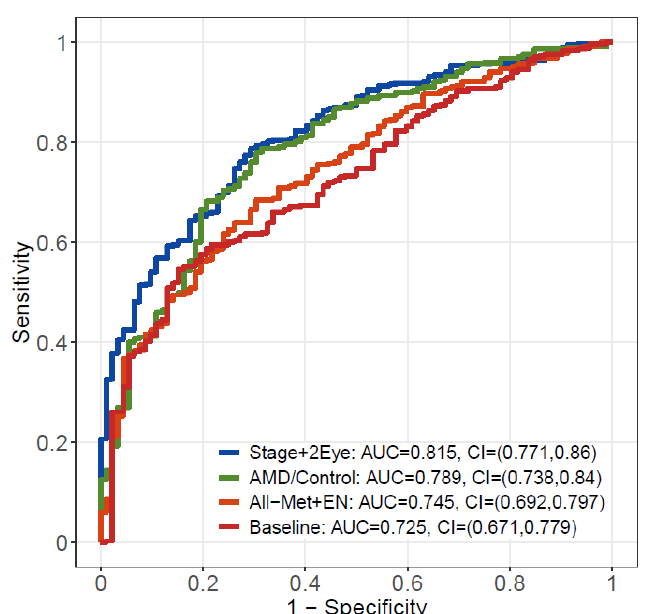
Figure 4. Receiving operating characteristic (ROC) curve analysis from the meta-analysis of the results of the two studies. In red, the baseline model including demographic covariates alone; in orange, the model including demographic covariates plus the metabolites selected by elastic net regression with all metabolites; in green, the model including demographic covariates plus the significant metabolites identified by AMD / Control model; in blue, the model including demographic covariates plus the significant metabolites identified by Stage + 2Eye model. AUC – area under the curve; CI – confidence interval; AMD – age-related macular degeneration; Stage + 2 Eye – permutation-based cumulative logistic regression model considering both eyes of each patient and the severity stage of disease as the outcome (control, early, intermediate and late); AMD / Control - multivariable logistic regression model considering AMD vs controls as the outcome; All-Met + EN – elastic net regression model with all metabolites; Baseline - statistical model only considering demographic covariates